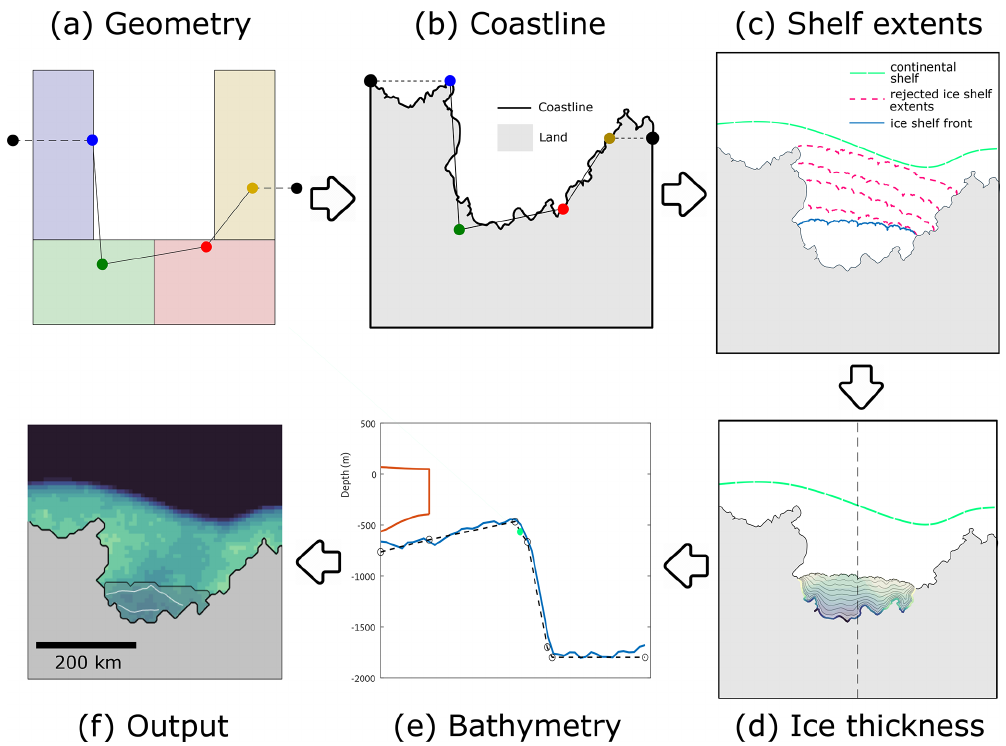
Figure A1. Flowchart showing the steps leading to generation of a random ice-shelf geometry, consisting of (a) generation of corner nodes randomly located within the four coloured polygons, (b) creation of a continuous fractal coastline, (c) definition of ice shelf and continental shelf horizontal extents, (d) definition of ice thickness at the grounding line and from this the full 2D ice-shelf draft, and (e) generation of a bathymetry constrained by the previous steps, leading to (f) one randomly sampled ice-shelf geometry (background colour map represents ocean bathymetry, and contours are ice-shelf draft, following the same ranges as in Fig.